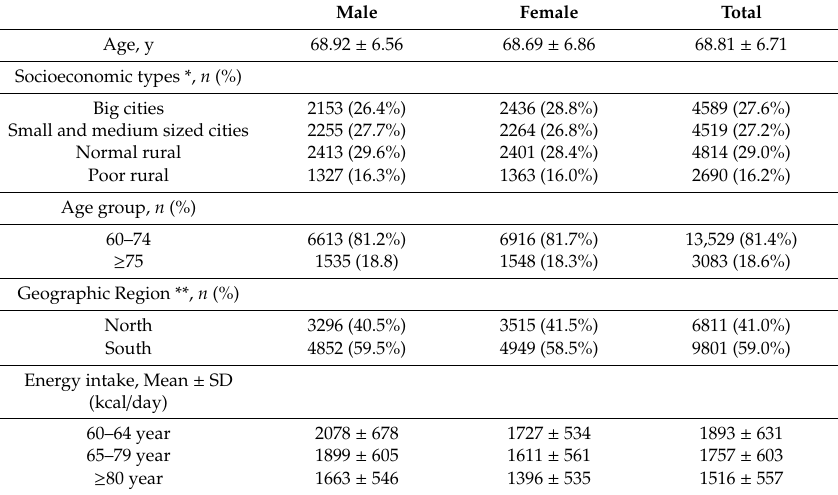
Table 1. Characteristics and usual dietary energy intake of subjects in the